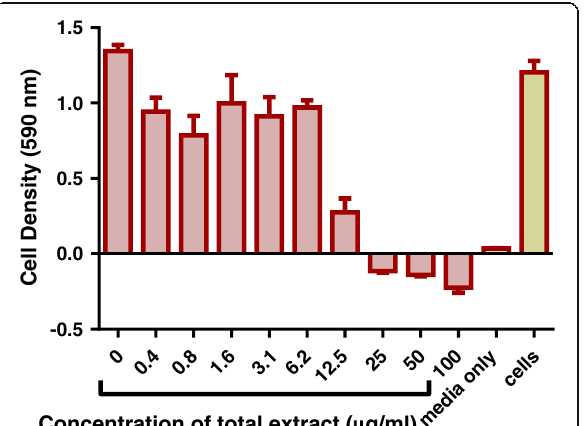
Fig. 4 The effects of P. curatellifolia total extract on M. smegmatis growth. The M. smegmatis mc 2 155 laboratory strain at a concentration of 2 × 10 6 cfu/mL was treated with the total extract from concentration of 0 μ g/ml to 100 μ g/ml of the plant extract. The bacteria were incubated with extracts at 37 ̊ C for 20 h and cell density was determined by measuring absorbance of reduced MTT at 590 nm. The error bars on the graphs indicate the standard deviation from mean ( n = 4). Dunnet ’ s multiple comparison test was used to compare the columns using graph pad prism 5 software. The asterisks (*) indicate statistical significant differences with the sterility control (media) * < 0.05 *** 0.0001